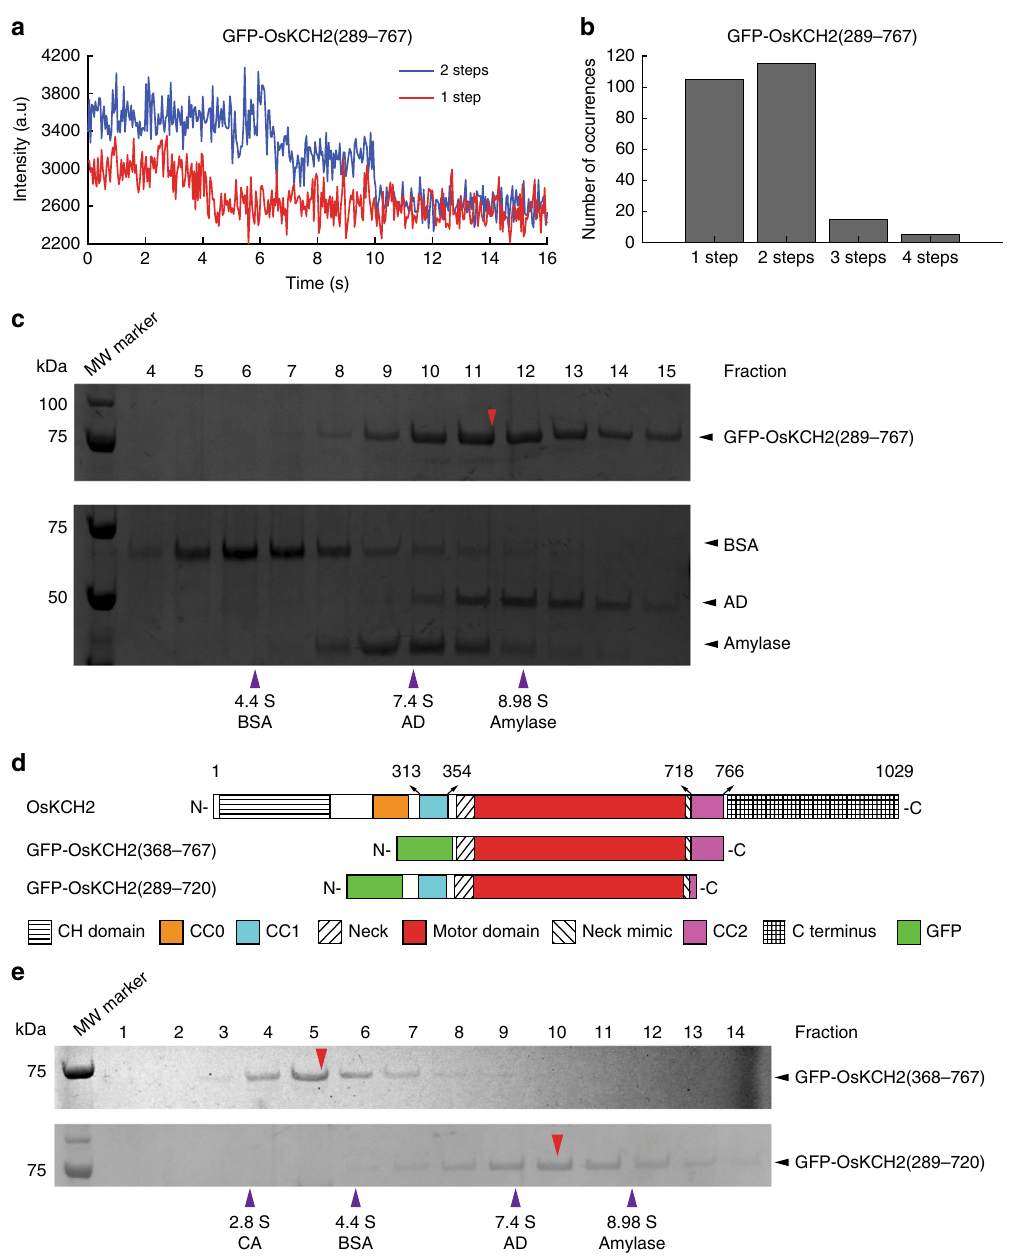
Fig. 3 GFP-OsKCH2(289-767) forms a homodimer via CC1. a Example fl uorescence intensity traces over time of individual GFP-OsKCH2(289 – 767) molecules immobilized on the microtubules. b Histogram of the photobleaching steps of GFP-OsKCH2(289 – 767) ( n = 240). c SDS-PAGE analysis of fractions from the sucrose gradient centrifugation assays of GFP-OsKCH2(289 – 767) (top) and the standard proteins (bottom). For each protein, the band intensity distribution was fi t to a Gaussian function to determine the peak fraction. Red arrowhead corresponds to the estimated peak fraction position of GFP-OsKCH2(289 – 767); and purple arrowheads correspond to the estimated peak fraction positions of the standard proteins as indicated. The molecular weight of GFP-OsKCH2(289 – 767) was estimated to be 177.9± 3.8 kDa (mean ± s.d., n = 3). d Schematic diagrams of the full-length OsKCH2, GFP- OsKCH2(368 – 767), and GFP-OsKCH2(289 – 720). e SDS-PAGE analysis of fractions from the sucrose gradient centrifugation assays of GFP-OsKCH2 (368 – 767) (top) and GFP-OsKCH2(289 – 720) (bottom). Red arrowheads correspond to the peak fraction positions of GFP-OsKCH2(368 – 767) and GFP- OsKCH2(289 – 720); and purple arrowheads correspond to the peak fraction positions of the standard proteins as indicated. For each protein, the peak fraction was estimated by fi tting the band intensity distribution to a Gaussian function. The molecular weights of GFP-OsKCH2(368 – 767) and GFP- OsKCH2(289 – 720) were determined to be 60.9 ± 7.9 kDa and 155.7 ± 8.3 kDa, respectively (mean ± s.d., n =